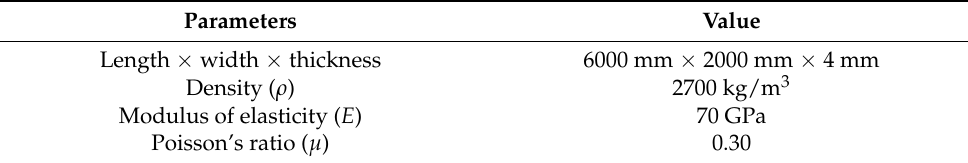
Table 3. Material properties of solar panel.